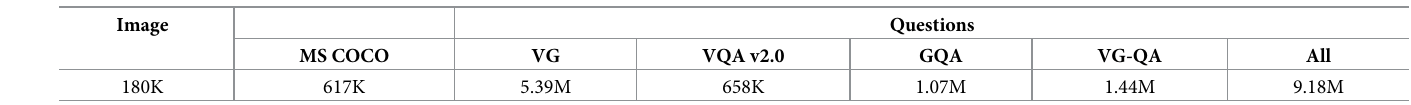
Table 1. Pre-training data